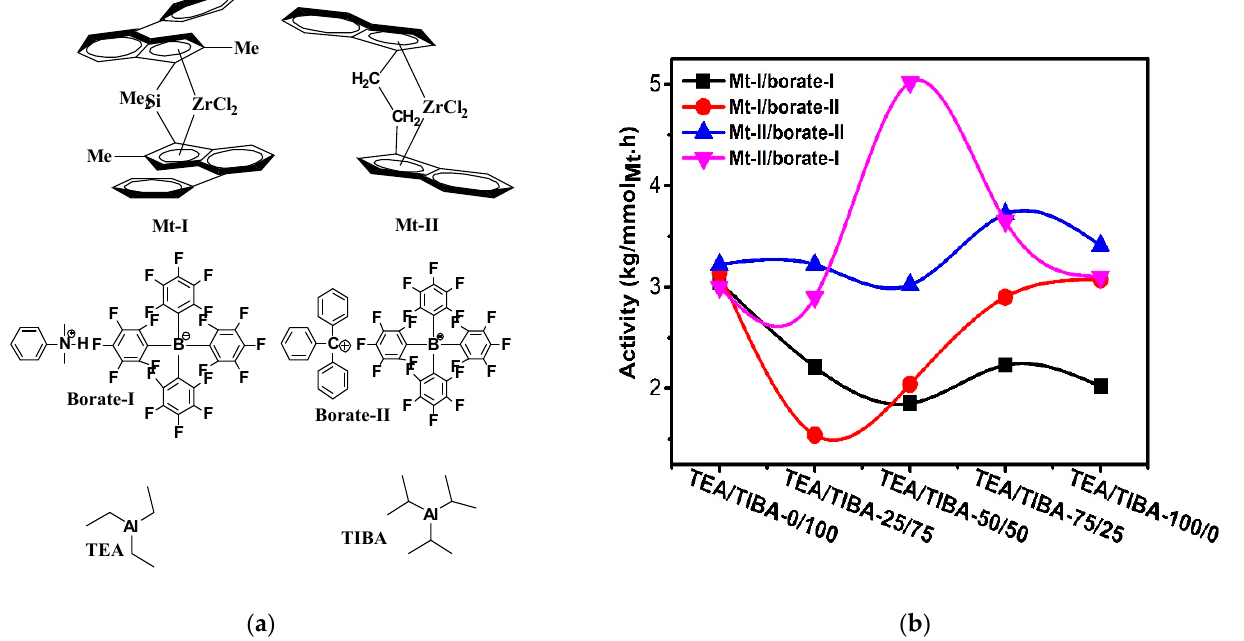
Figure 1. ( a ) Metallocene catalysts, borates and alkyl aluminums used in this work; ( b ) changes of activity with type of alkylaluminum triisobutylaluminium ( TIBA)/ triethylaluminium ( TEA) mixtures. alkylaluminum triisobutylaluminium (TIBA)/triethylaluminium (TEA)